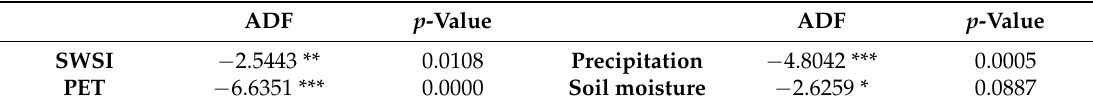
Table 3. The ADF test.